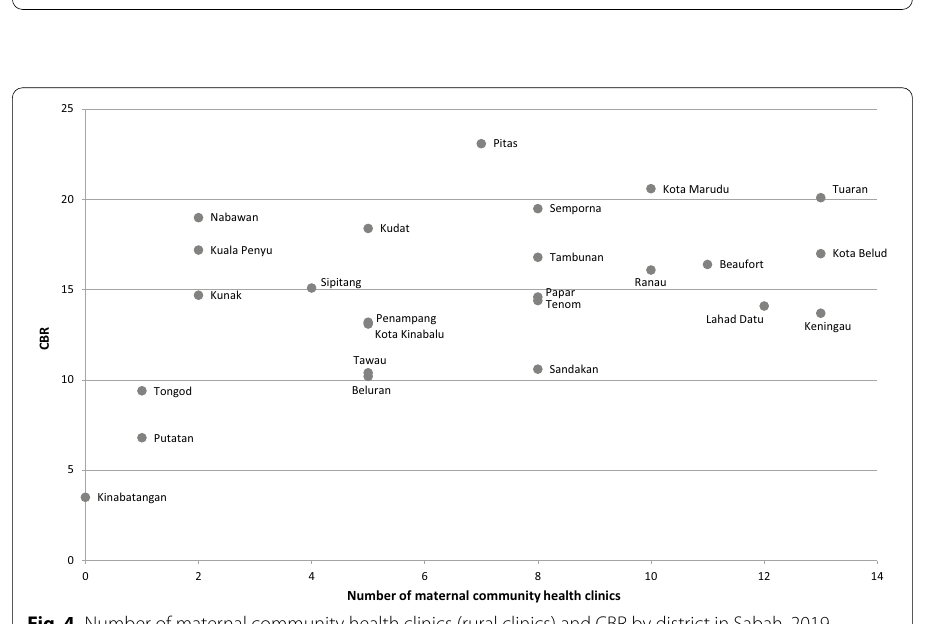
Fig. 4 Number of maternal community health clinics (rural clinics) and CBR by district in Sabah, 2019. Spearman correlation coefficient 0.405, p 0.045. Sources: Vital statistics, Malaysia, 2020; Statistics yearbook, = = Sabah, 2019 (DOSM, 2020f; DOSM,